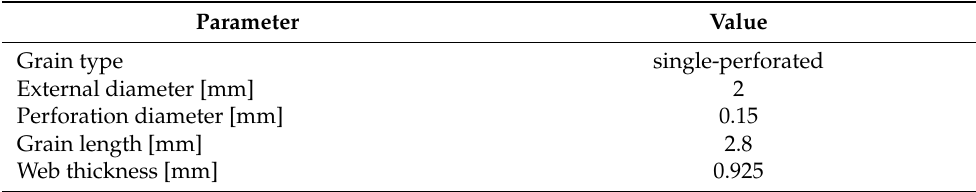
Figure 2. Grains shapes of investigated propellant. Table 1. Propellant grain characteristics.